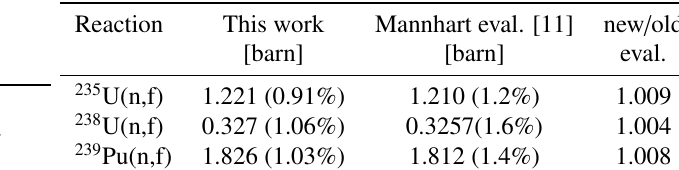
Table 11: Evaluated experimental SACS in 252 Cf(sf) neu- tron spectrum vs Mannhart original evaluation [11]. These values together with correlations listed in Table 12 repre- sent our best experimental knowledge and are independent of the evaluated 252 Cf(sf) neutron spectrum.